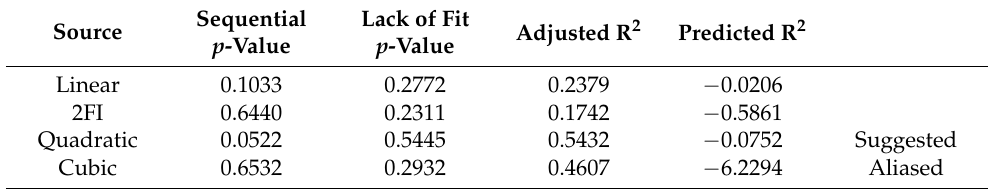
Table 6. Fit summary for COD response.